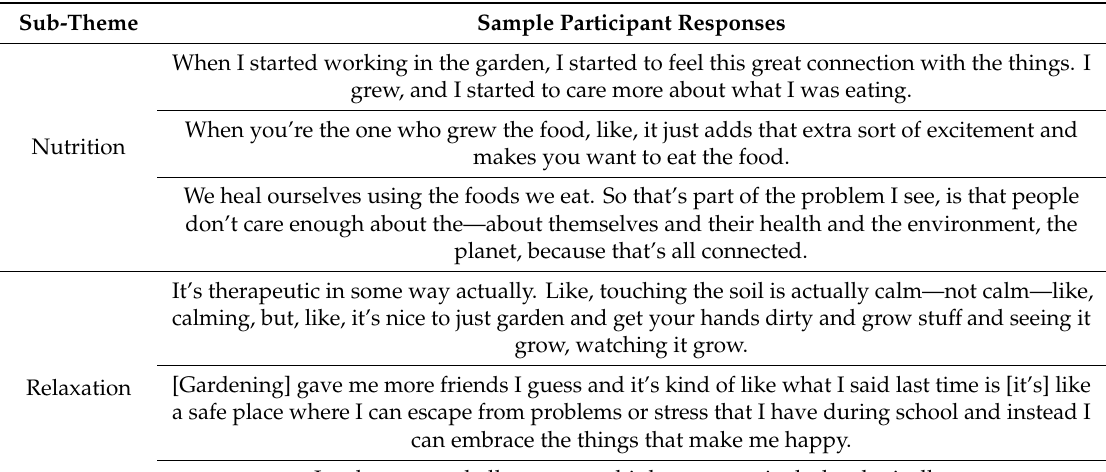
Table 3. Theme: personal health.